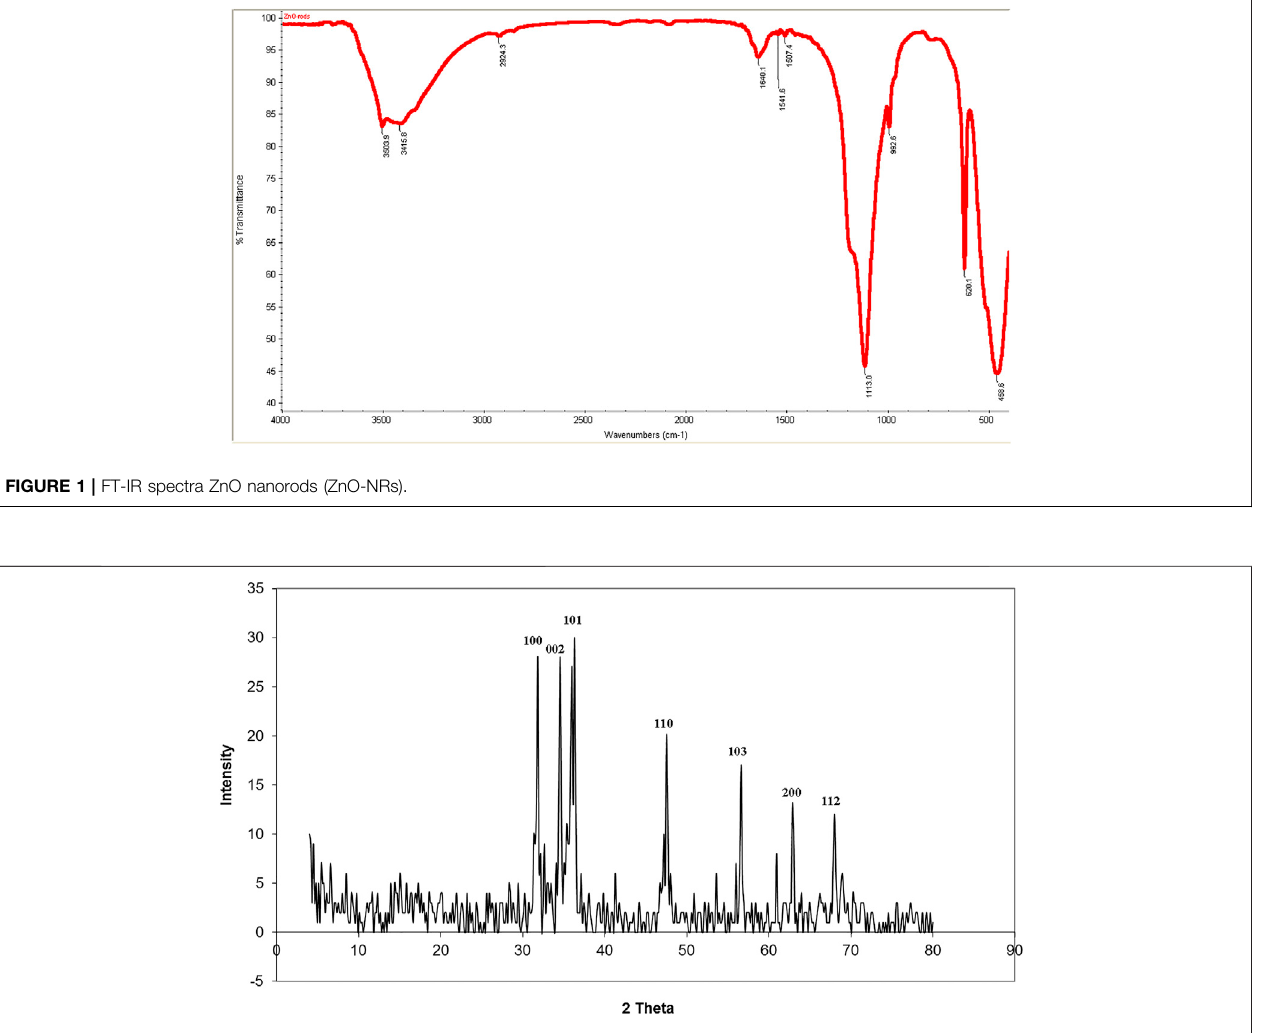
Figure S2 . The obtained results are in total agreement with the results of the XRD data presented in Figure 2 .